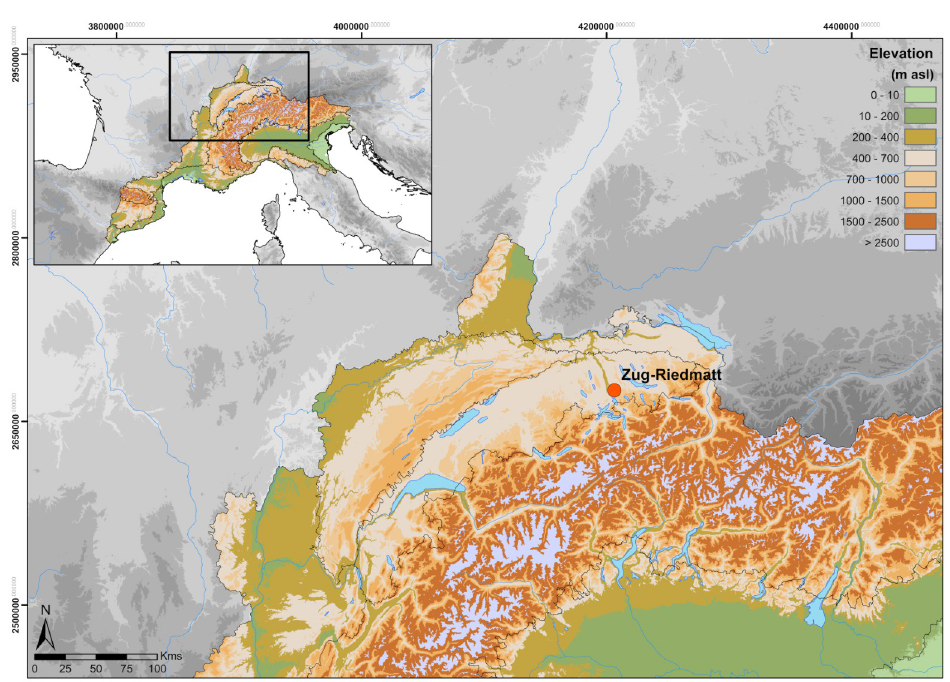
Fig 1. Location of the settlement of Zug-Riedmatt (Canton of Zug, Switzerland) and in colours the extension of the area of the AgriChange research project. Software: QGIS3.6, © European Union, Copernicus Land Monitoring Service [2016], European Environment Agency